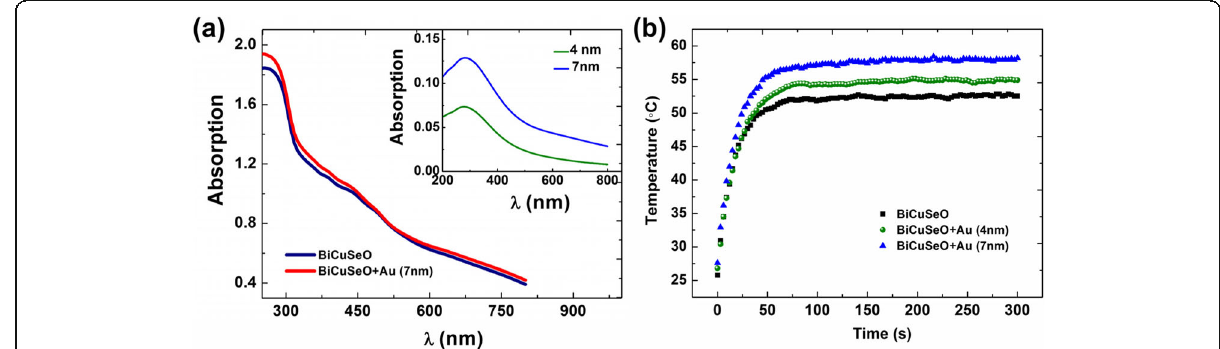
Fig. 2 a Light absorption spectra of bare BiCuSeO and AuNPs (7 nm)/BiCuSeO samples. The inset is the light absorption spectra of Au layer with a thickness of 4 nm and 7 nm. b Heating curves of bare BiCuSeO and AuNPs/BiCuSeO samples under the Xenon lamp